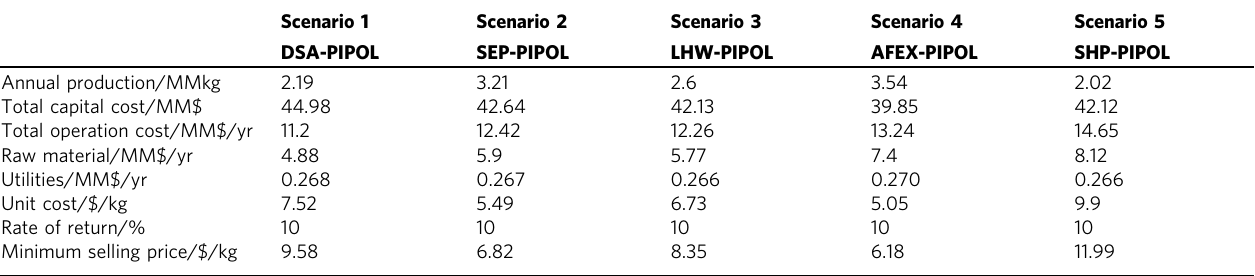
Table 1 Techno-economic analysis (TEA) of the biological lignin valorization to polyhydroxyalkanoates (PHAs).